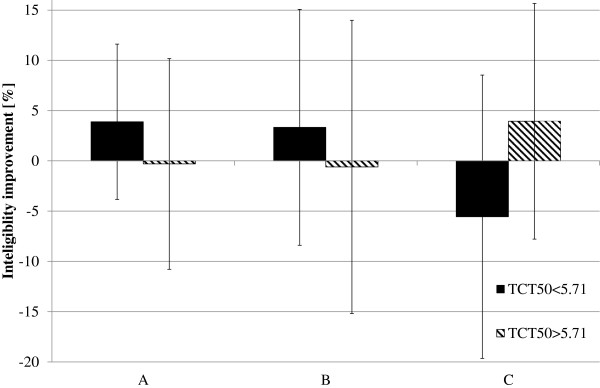
Average improvement in WER for the input speech with average rate equal to ROSmean2.